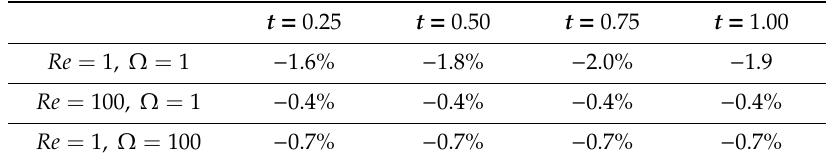
Table 2. Wall shear stress percentage error ( n = 0.5, ε = Table 1. Discharge percentage error ( 𝑛 = 0.5 , 𝜀 = 0.1 ).